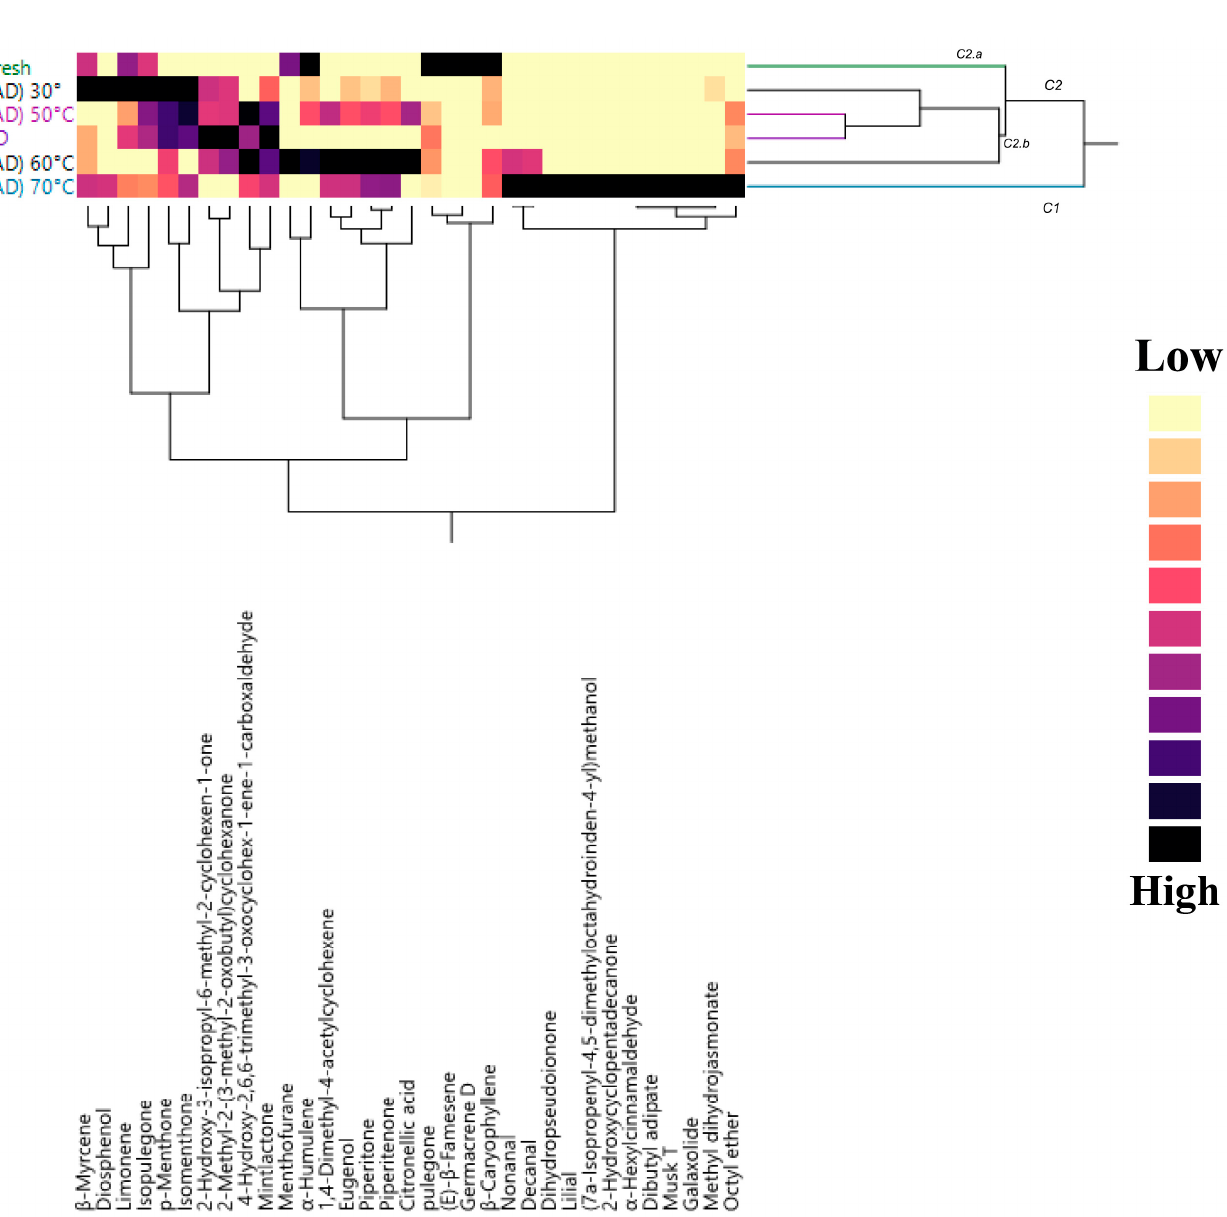
Figure 2. Dendrogram of cluster hierarchical analysis performed on VOCs from A. aurantiaca ‘Apricot Sprite’